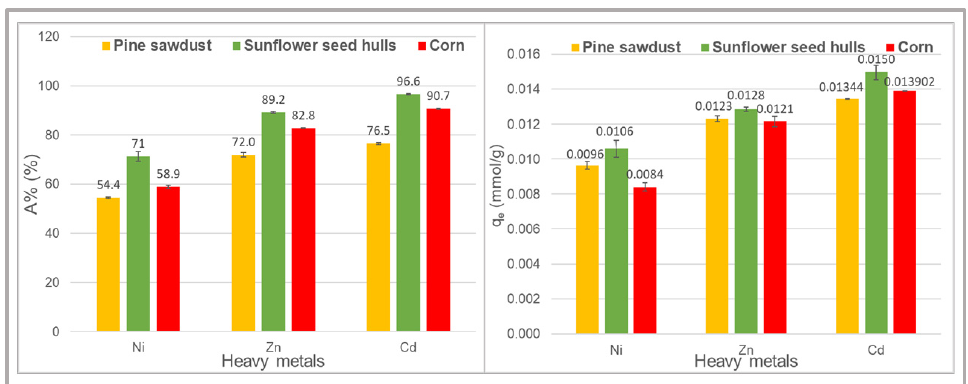
Figure 9. Comparison of the adsorption of mono-metal solutions of Ni(II), Zn(II) and Cd(II) on pine sawdust, sunflower seed hulls and corn residues mix.